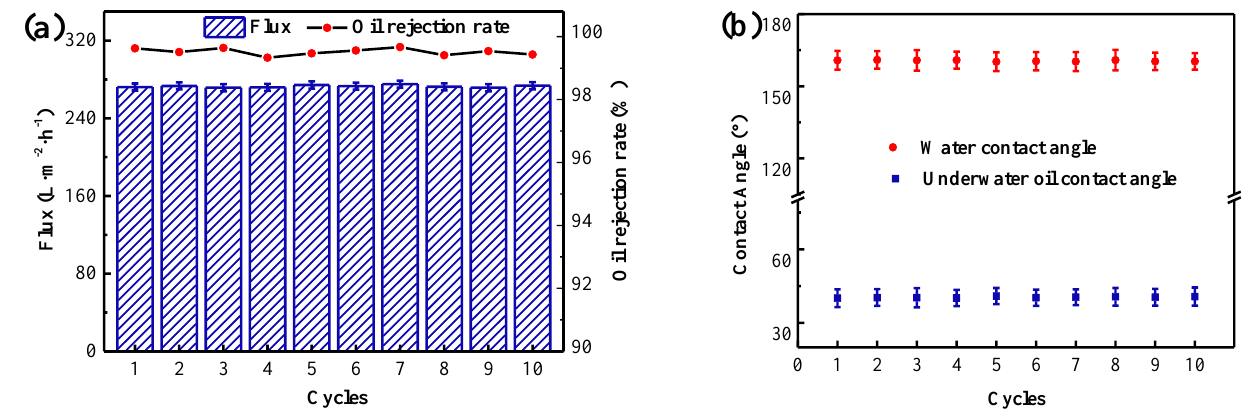
Figure 9. The long − term operation stability of M-3 membrane for O/W emulsion separation. ( a ) Water flux and oil rejection. ( b ) Water contact angle and underwater oil contact angle. Table 4. Comparison of various membranes used to separate oil-in-water emulsions.